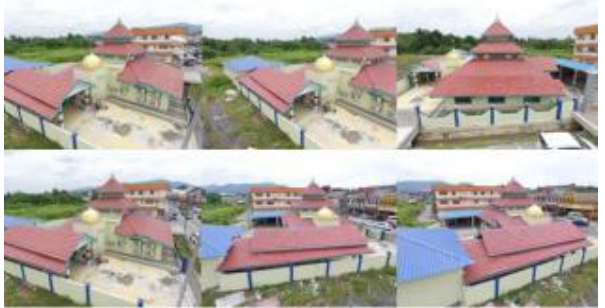
Figure 2. Images capture using Phantom 3 Pro from different perspective